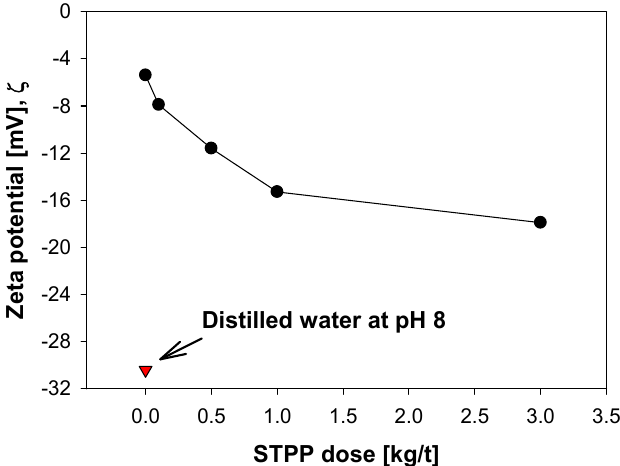
Figure 6. Effect of sodium tripolyphosphate (STPP) on zeta potential of kaolin slurries (5 wt%) in seawater at pH 8. Zeta potential in distilled water at pH 8 is − 30.4 mV.